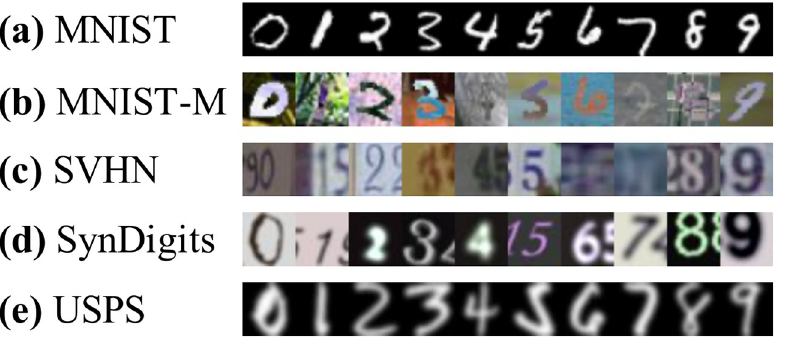
Fig 4. Sample images (10